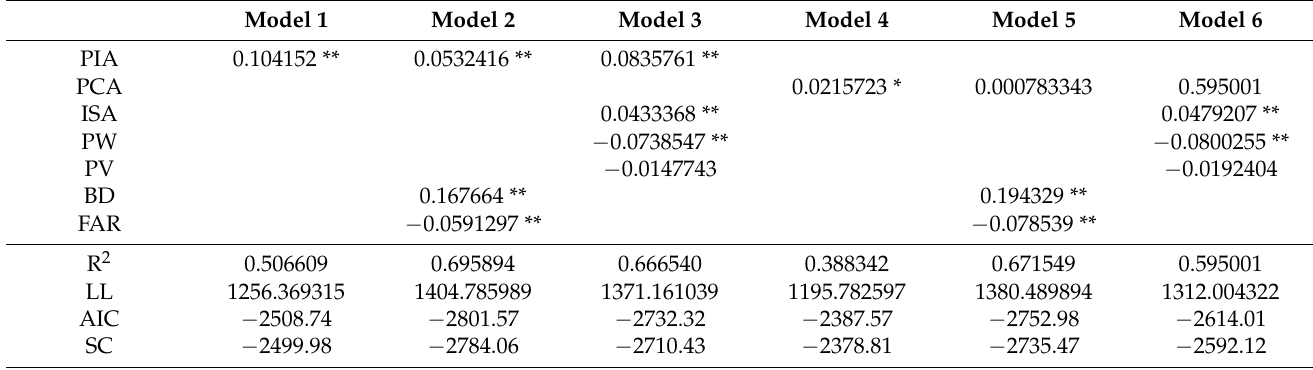
Table 6. SEM (spatial error model)